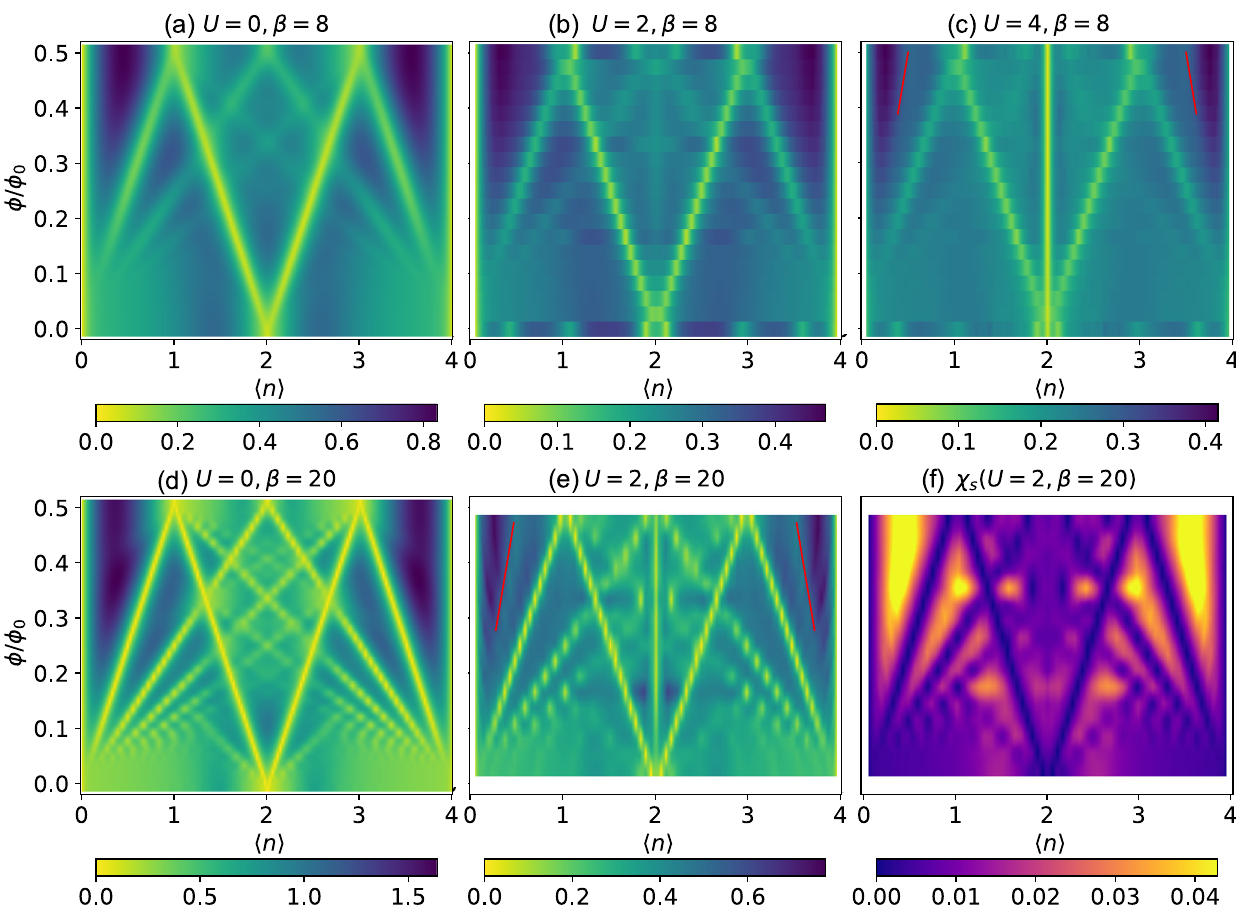
Fig. 2 Compressibility and spin correlation in the presence of interactions. Compressibility as a function of magnetic fl ux and electron density in an N site = 36 × 36 × 2 cluster for ( a , d ) U / t = 0; an N site = 6 × 6 × 2 cluster for ( b , e ) U / t = 2 and ( c ) U / t = 4. The fi rst row is for the inverse temperature β = 8/ t and the second row for β = 20/ t . Panel ( f ) shows the corresponding spin correlation at U / t = 2 and β = 20/ t . It has a reverse color bar compared to those of the charge